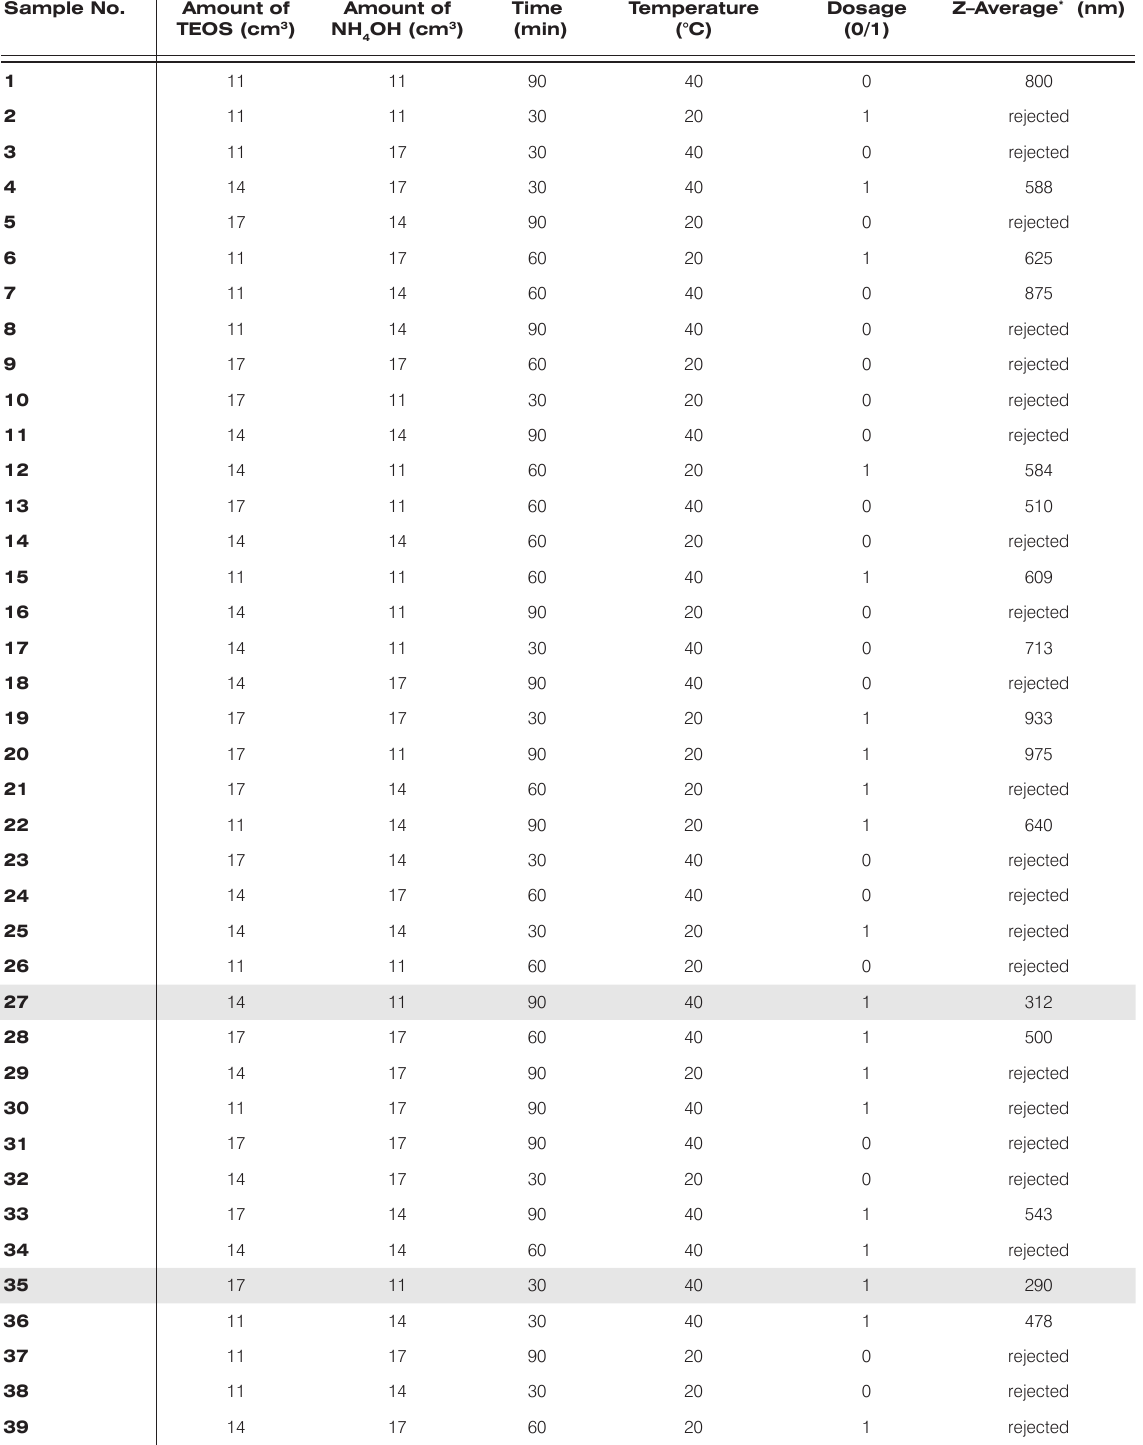
Table 1. List of silica samples and the Z–Average particle size results. Sample